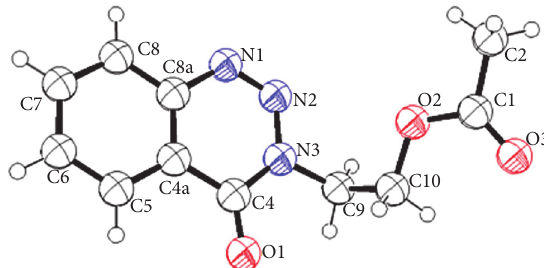
Figure 1: Molecular structure of 7a (ORTEP drawing showing 50%